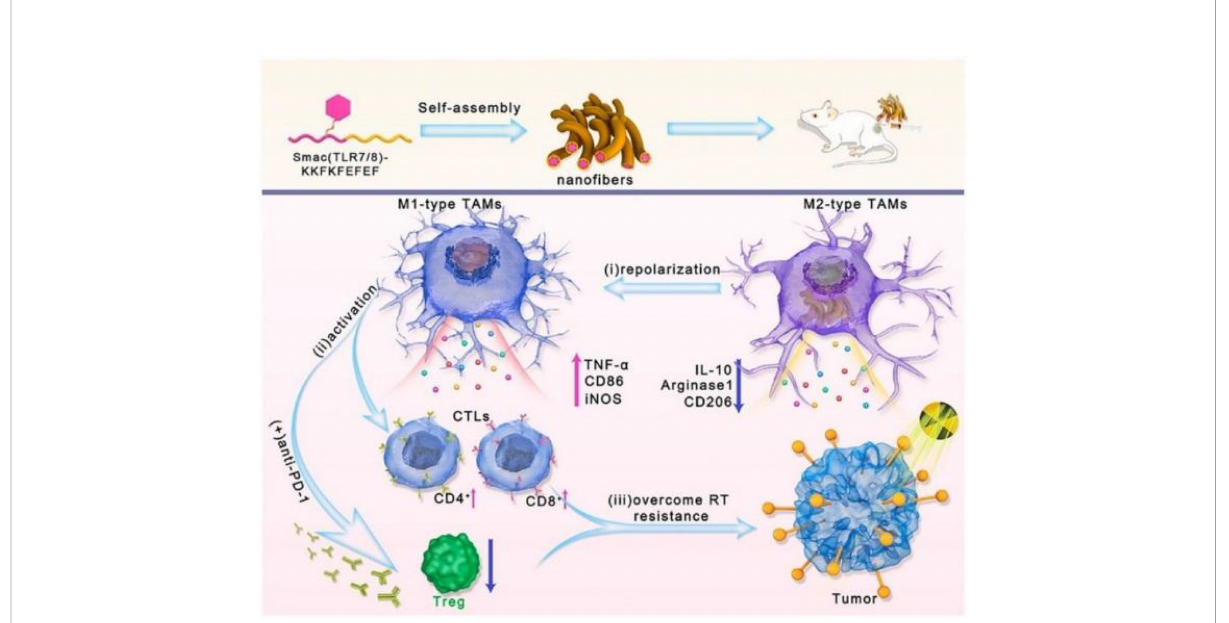
FIGURE 7 Schematic of the Smac-TLR7/8 hydrogel regulates macrophage repolarization to overcome radioresistance (133). Reprinted with permission from Ref.